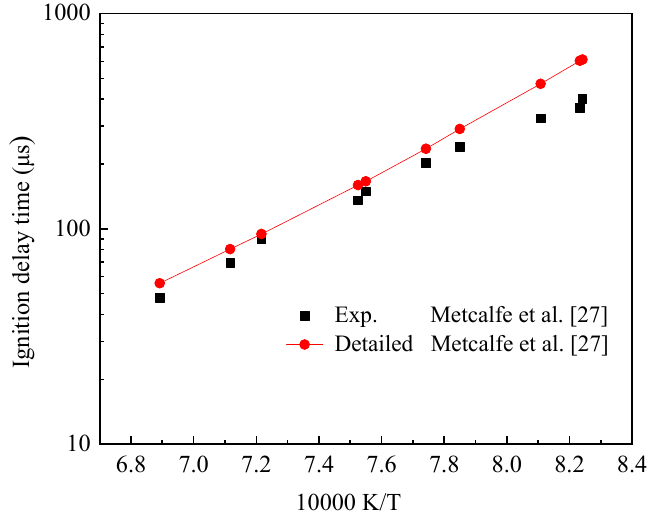
Figure 1. IC 8 H 16 detailed mechanism verification.